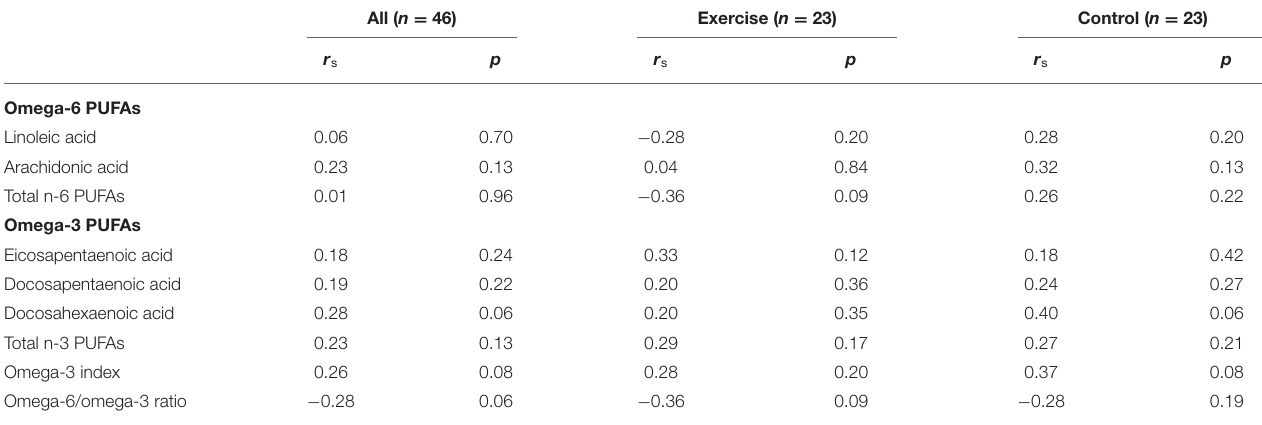
TABLE 1 | Correlations between blood polyunsaturated fatty acid compositions and change in cancer-related fatigue over 12 weeks. All ( n = 46) Exercise ( n = 23) Control ( n =